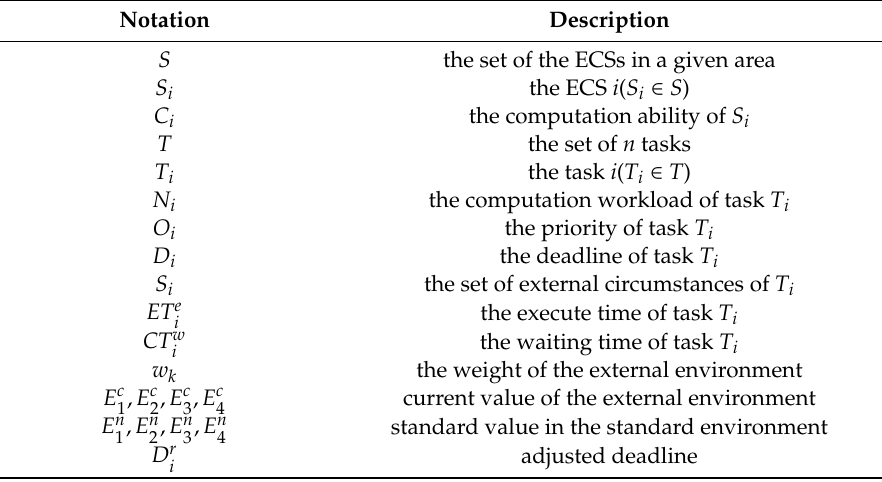
Table 1. Lists of major used